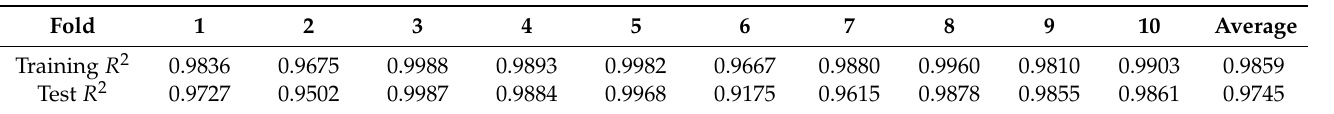
Figure 4. The comparisons of training and test thermal conductivities by fold 3 with the measured ones for WC-Ag system. 3.2. DNN Model for WC-Co System In our previous work, it was found that the thermal conductivity for two-phase WC- Co system abruptly changes at 695 K due to the phase transition of the binder phase Co [7]. It should be noted that in Ref. [7], XRD (X-ray diffraction) and SEM (Scanning Electron Microscope) were conducted, which can verify the two-phase structure of prepared WC- Co samples. Therefore, in order to obtain reasonable calculation results by physical